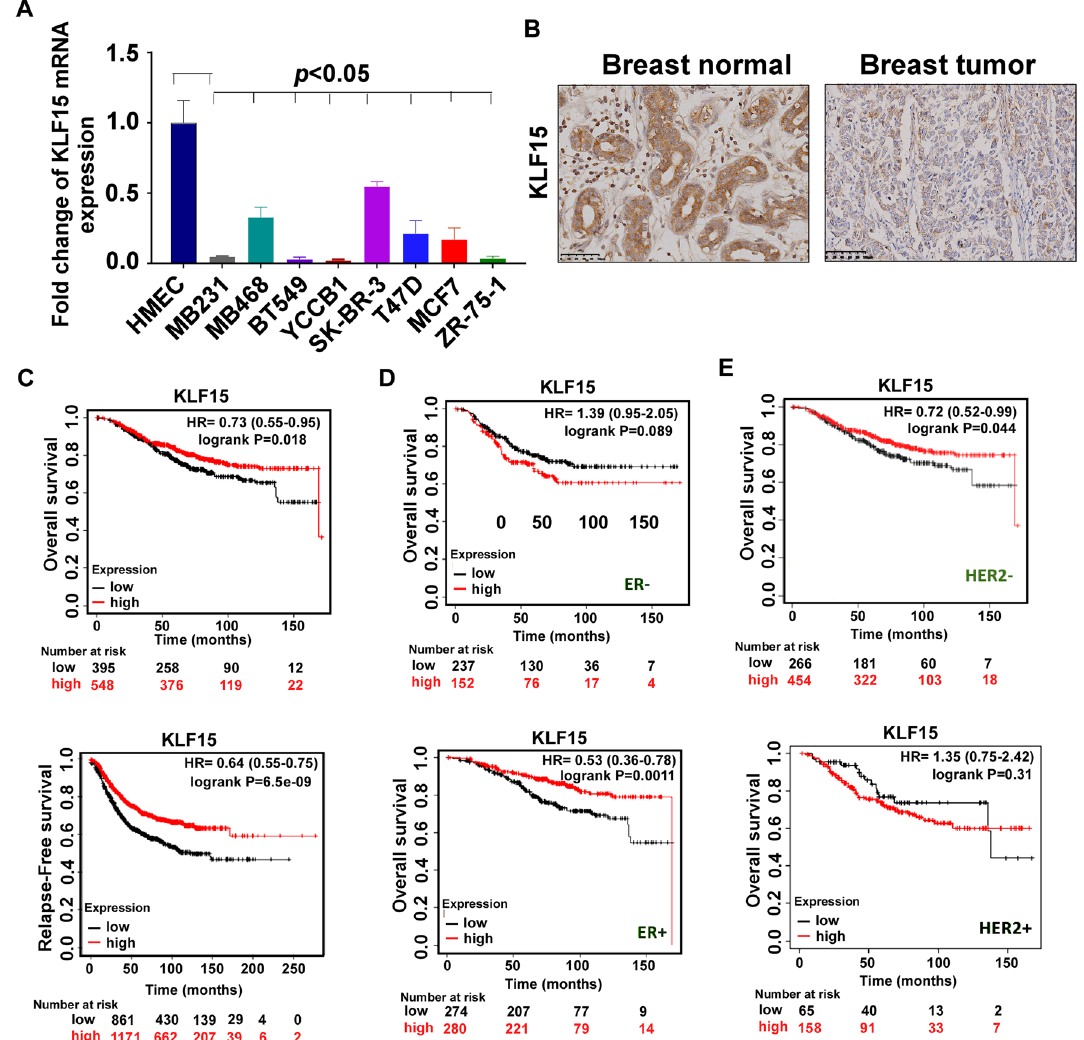
Figure 1. The expression levels of KLF15 in breast cell lines and TNBC tissues. ( A ) Quantitative real-time PCR (qPCR) analysis of KLF15 mRNA expression in different breast cancer cell lines. HMEC was used as non-tumoral control. ( B ) Representative images of KLF15 IHC staining in breast tumor and para-cancerous tissue. ( C ) High expression of KLF15 were beneficial to breast cancer patient prognosis. ( D ) The expression level of KLF15 was a protective factor in ER+ status patients, as opposed to a risk factor in ER− status. ( E ) The expression value of KLF15 was a risk factor in HER2+ status patients, but a protective factor in HER2−